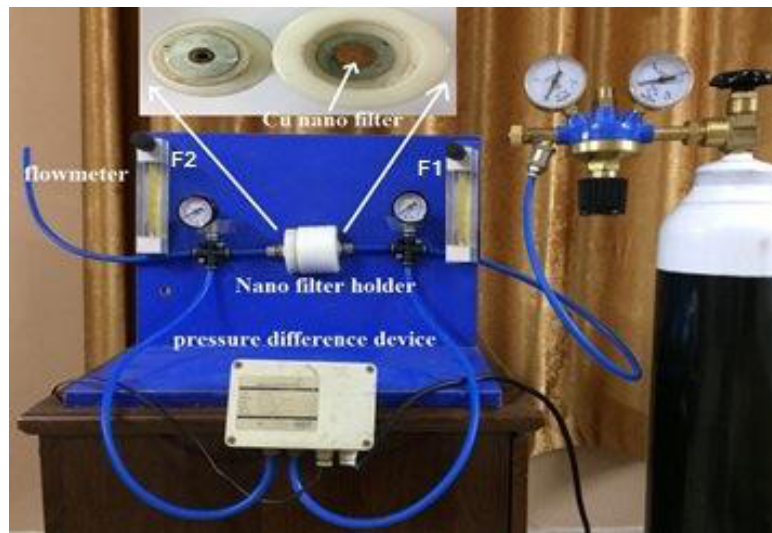
Fig. 1: Gas filter evaluation